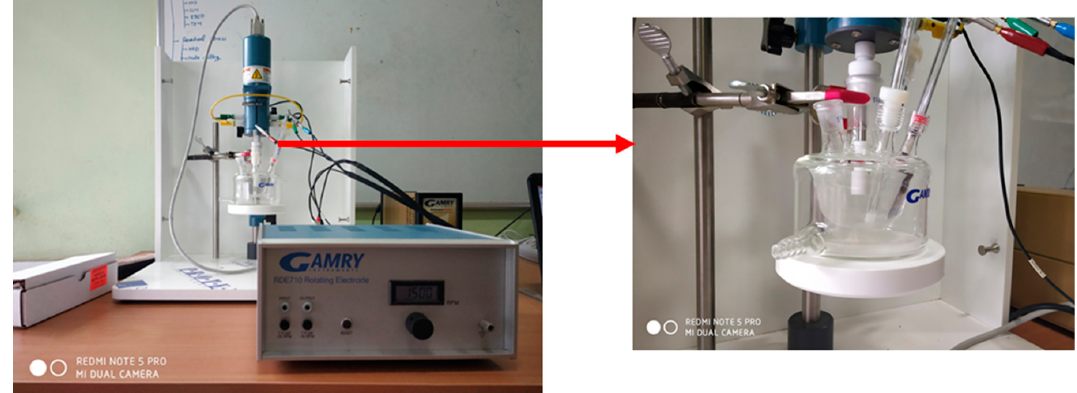
Figure 2. Photograph of the erosion ‐ corrosion test set ‐ up and photograph of the erosion corrosion chamber.